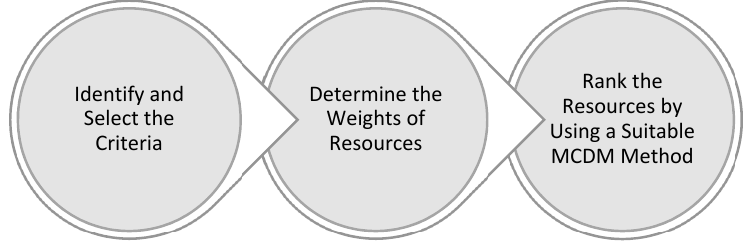
Figure 1. Steps of